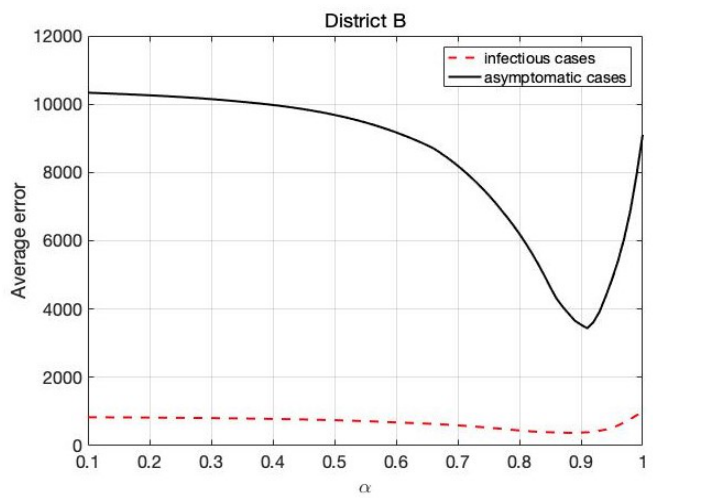
Figure 12. Model results for various